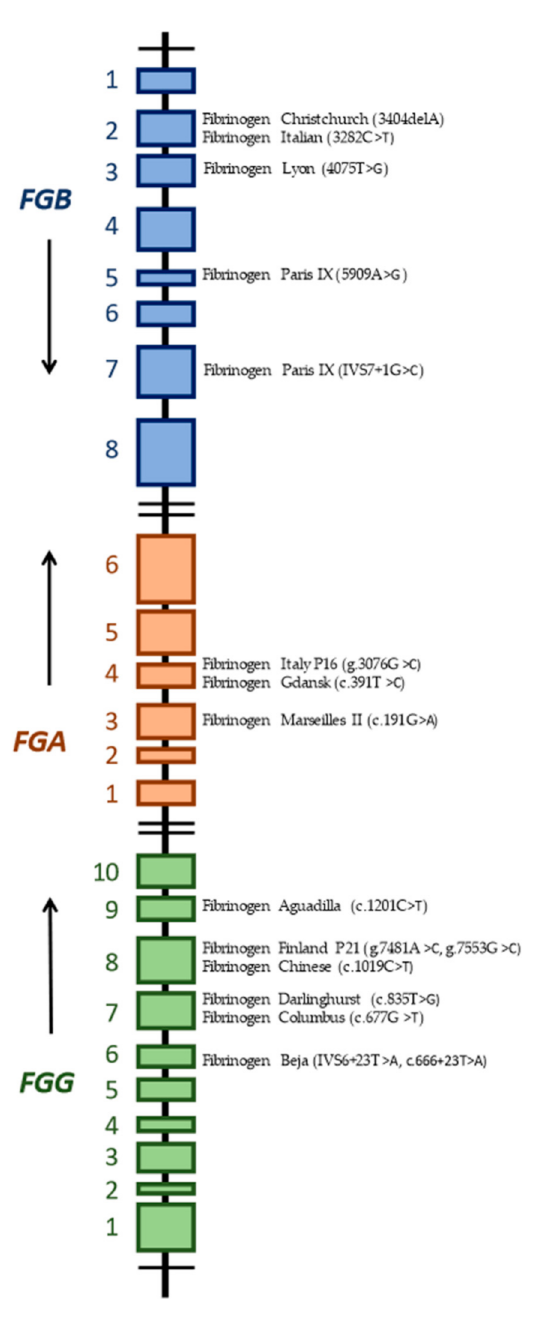
Figure 3. Schematic diagram of FGA , FGB, and FGG genes and the location of individual mutations associated with hypofibrinogenemia and thrombotic and bleeding